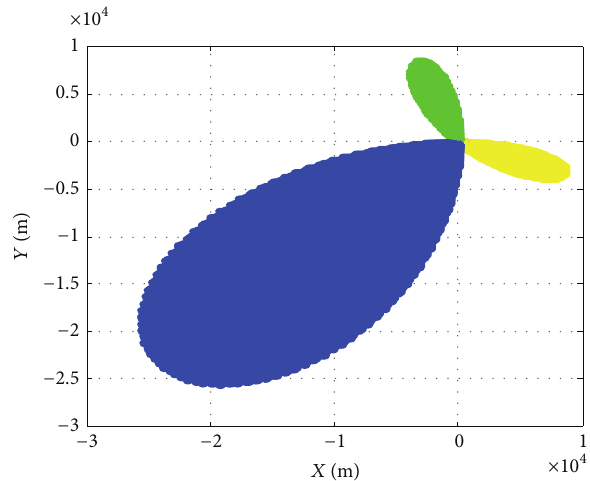
Figure 20: The 𝑋 - 𝑌 coordinates in which the TOA equation cannot be solved (within 2nd, 3rd, and 4th quadrants).